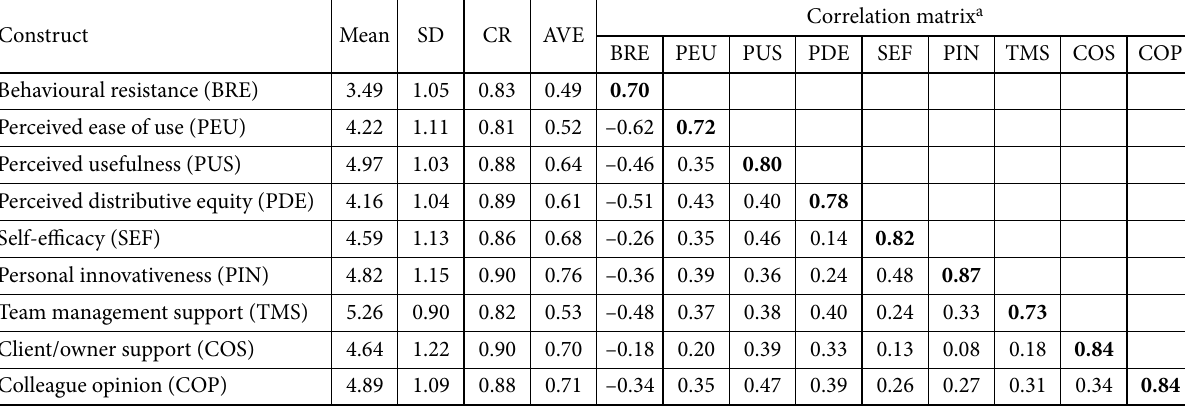
Table 3. Measurement validity and construct correlations